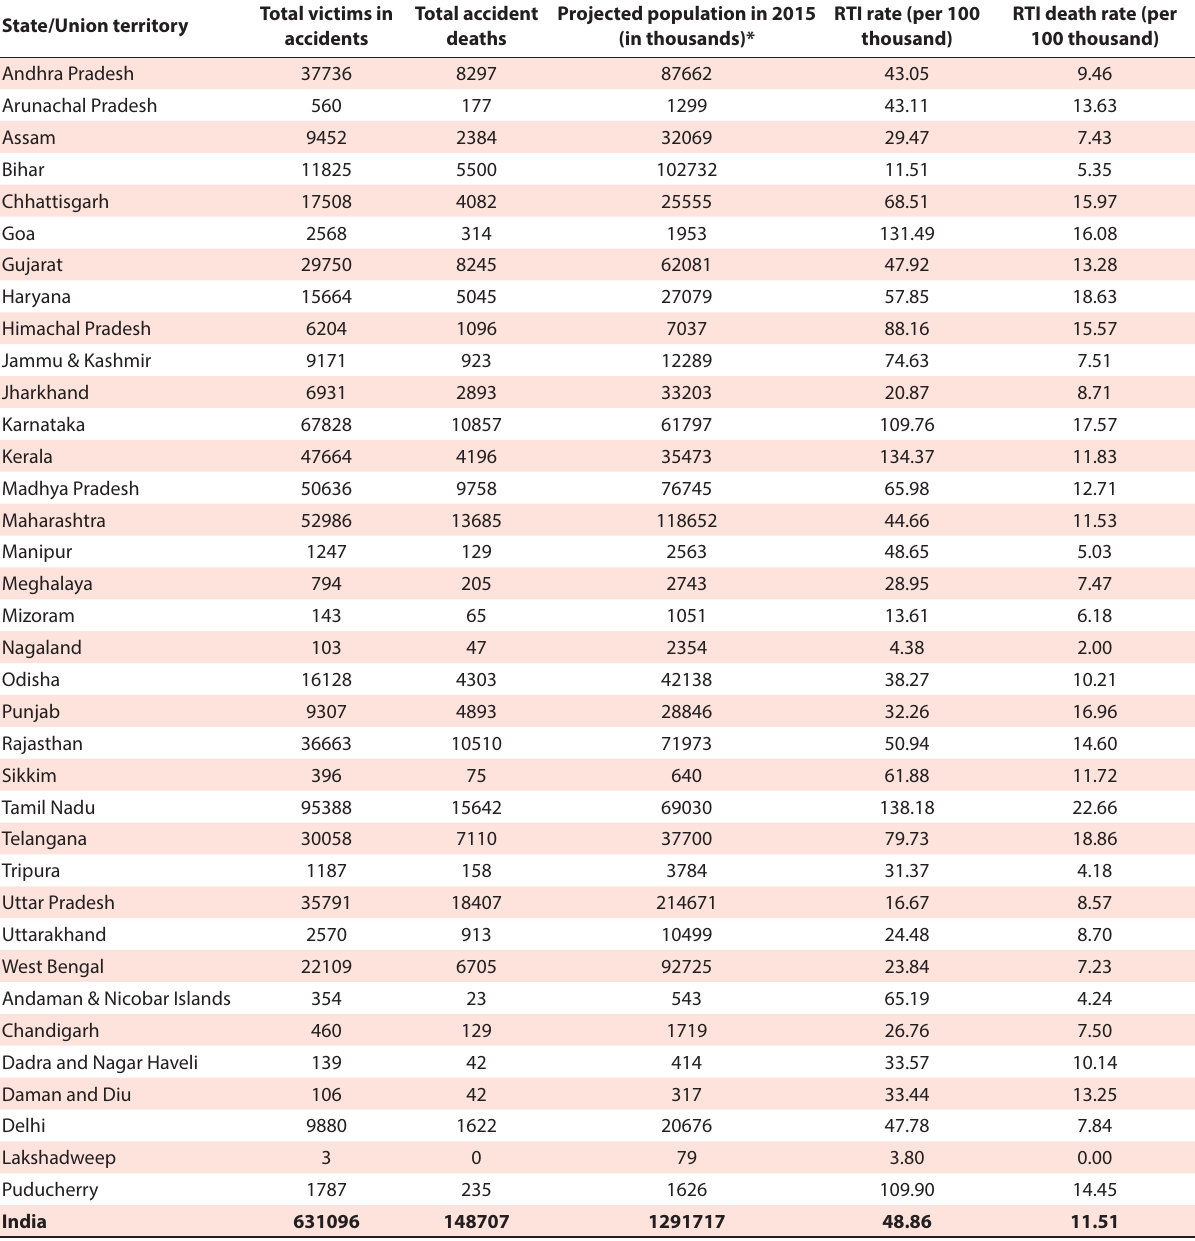
Table 1. State wise details of road traffic injuries (RTIs) and death in the year 2015 State/Union